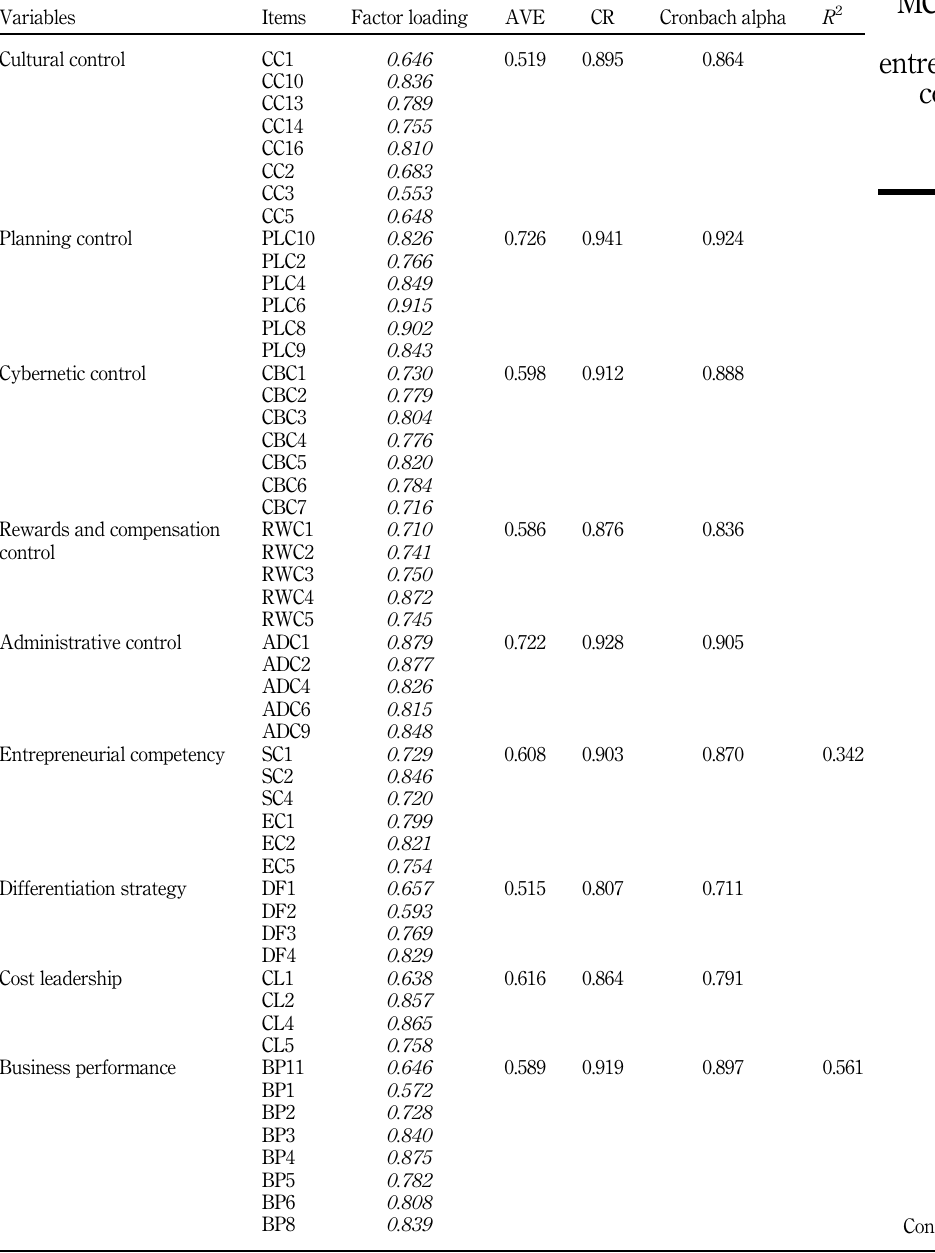
Table 5. Convergent